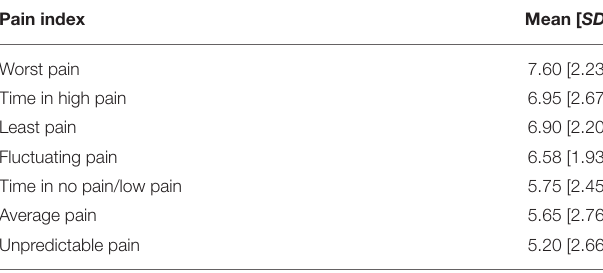
TABLE 2 | Mean [SD] of provider ratings of importance/usefulness of individual pain intensity